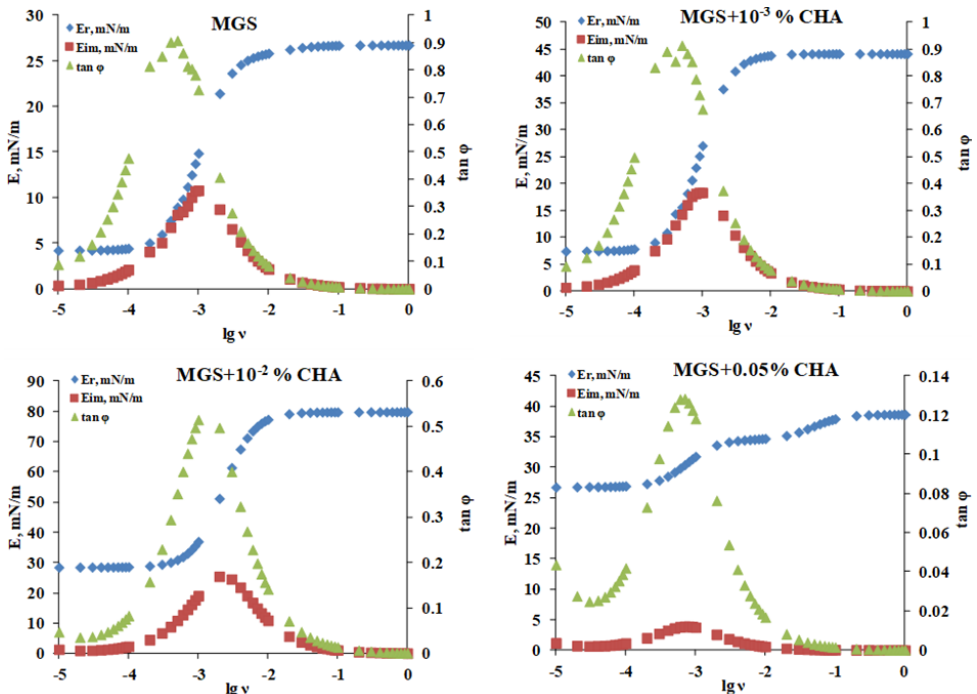
Figure 7. Fourier transformation analysis via Equations (3) and (4) of the stress relaxation transients of meibomian films alone and in the presence of CHA (see Figure 6).